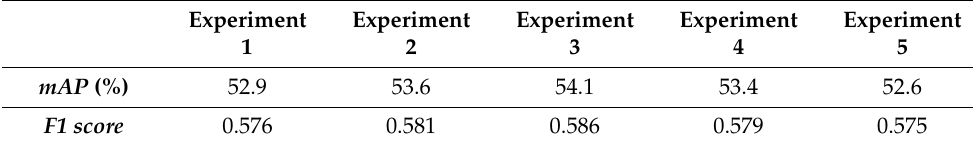
Table 5. Results of Faster R-CNN on TT100K dataset.